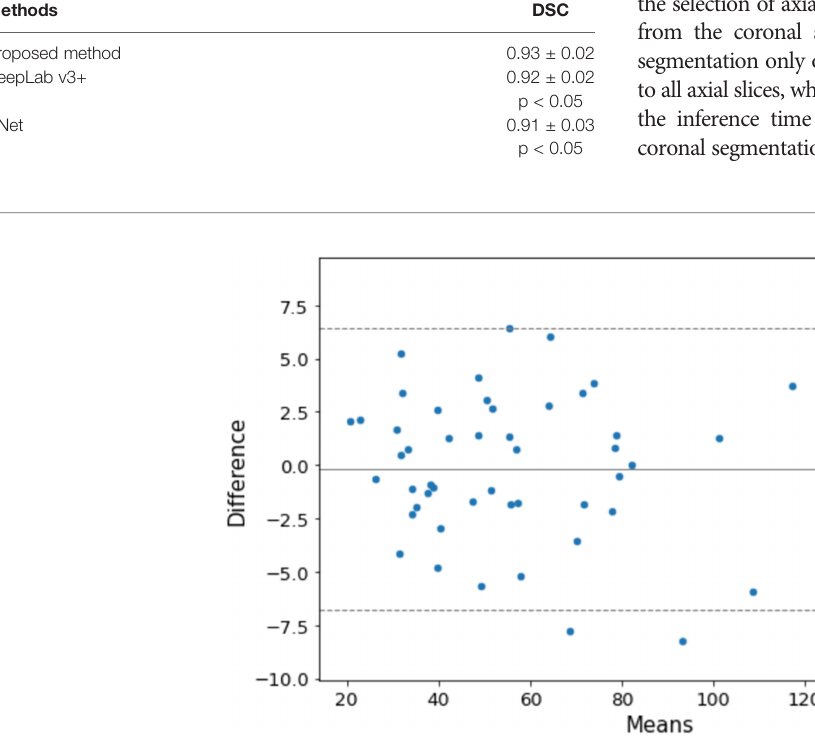
FIGURE 6 | Bland – Altman plot to show the agreement between manual and DANN-enabled WPG volume